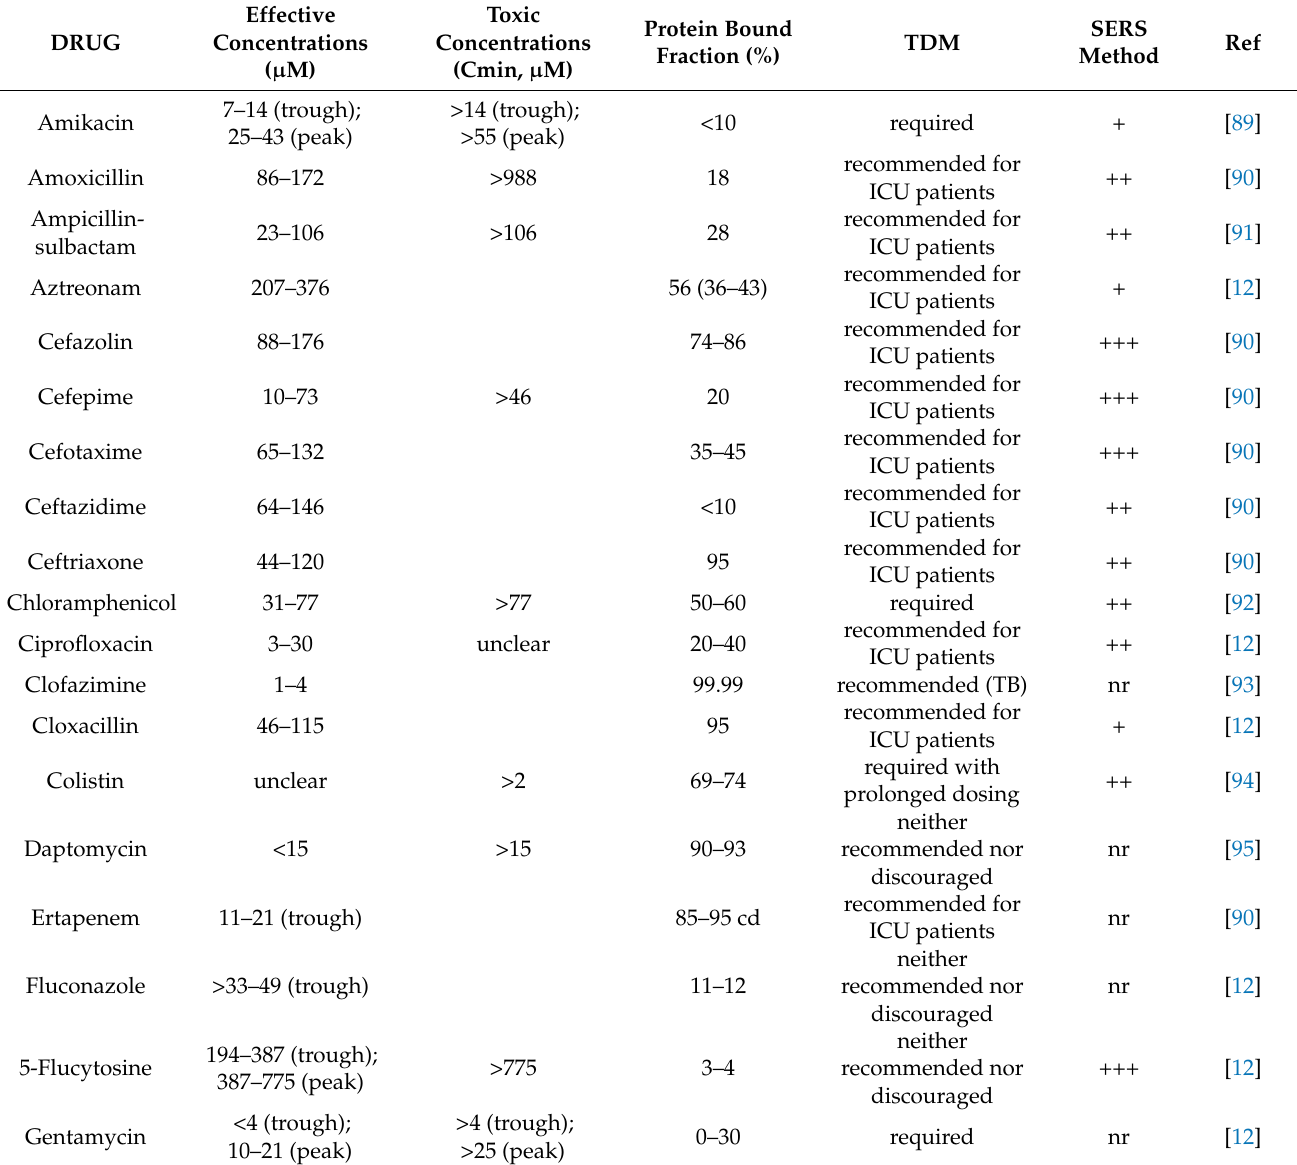
Table 3. Availability of SERS-based methods for the TDM of most commonly used antimicrobial